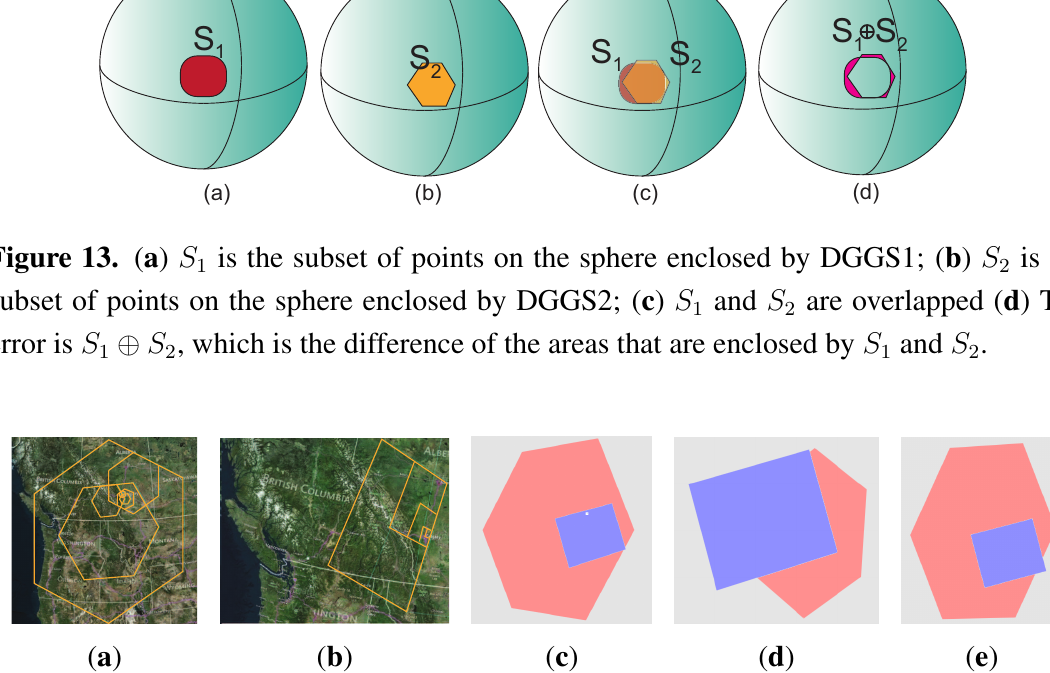
Figure 14. ( a ) Hexagonal cells of the PYXIS framework at several successive resolutions; ( b ) corresponding cells of (a) in Cube (one-to-four); ( c , d , e ) PYXIS cells at resolution three, six and seven and the corresponding cells in Cube (one-to-four) at resolution four, six and seven. Cells are uniformly scaled to provide better visualizations.